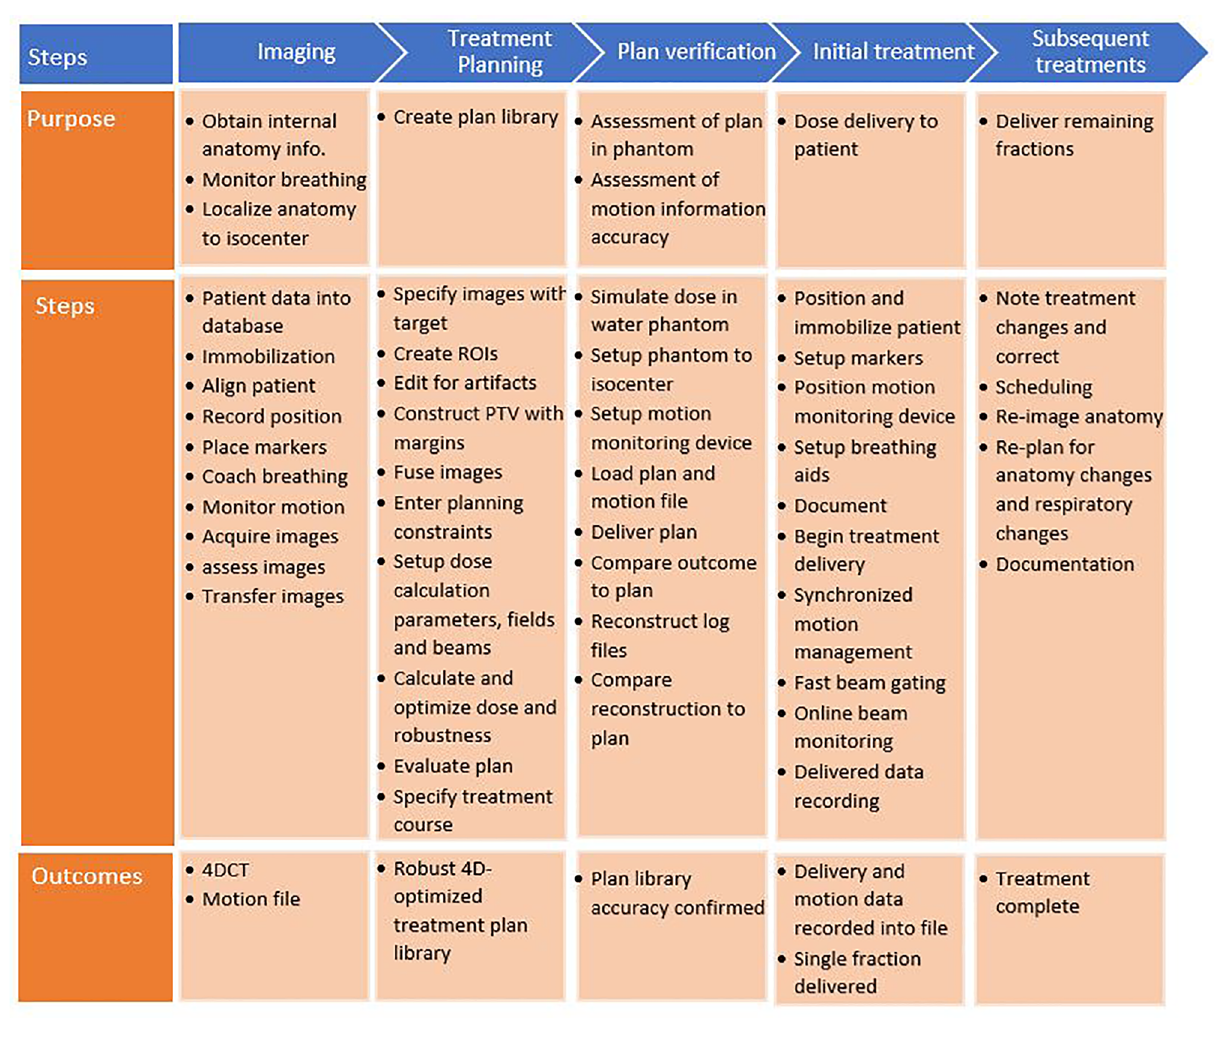
FIGURE 4 | Process map for motion-synchronized dose delivery as commonly found in ion therapy clinics. The treatment process is broken down into fi ve categories: imaging, treatment planning, plan veri fi cation, initial treatment fraction, and subsequent treatments. Each step in these processes is